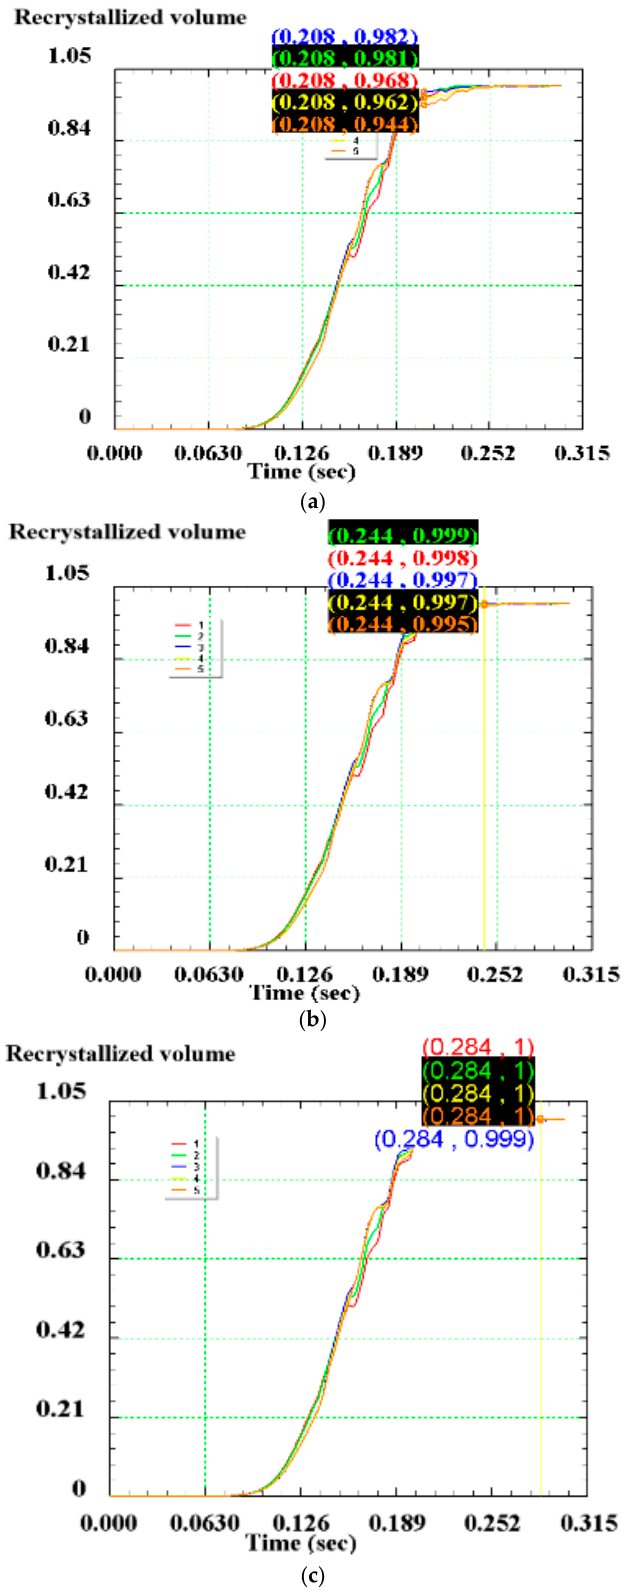
Figure 15. Dynamic recrystallization volume percentage of each tracking point: ( a ) L = 100%; ( b ) L = 125%; ( c ) L =